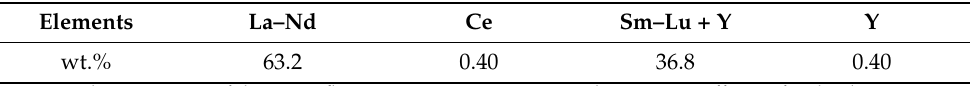
Table 3. Weight fractions of REM groups and some individual REMs in the eudialyte concentrate per total REM